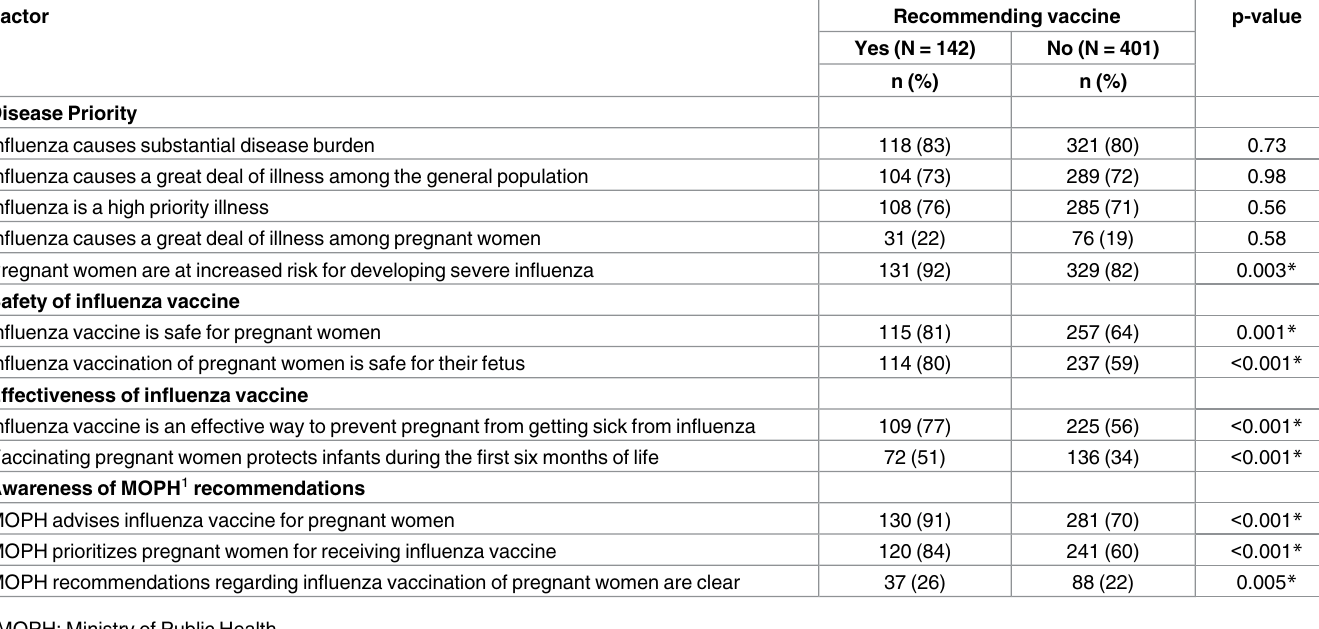
Table 3. Comparison of key perceptions among Thai physicians who recommend influenza vaccine and those who don’t in hospitals with influ- enza vaccine services(N = 543).